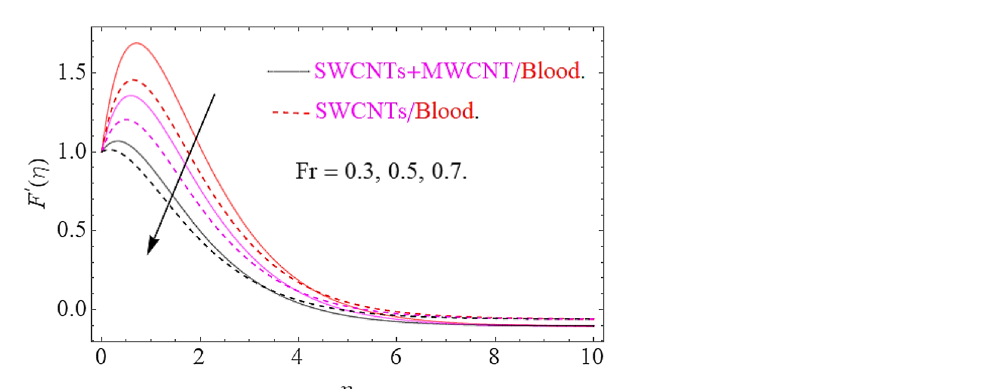
Figure 5. Influence of Fr on F ′ (η)